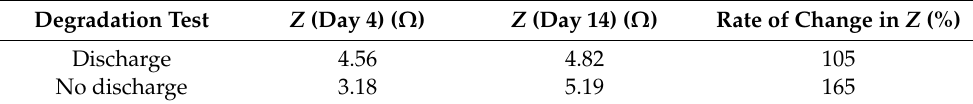
Table 4. Percentage change in Z in the degradation tests with and without discharge. Degradation